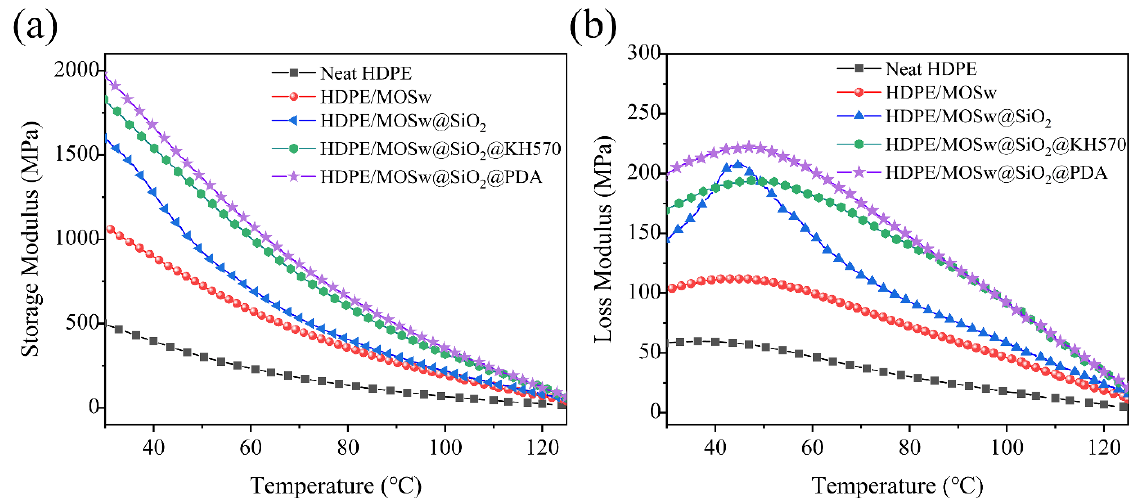
Figure 7. Schematic diagram of dynamic mechanical analysis of the composite materials.